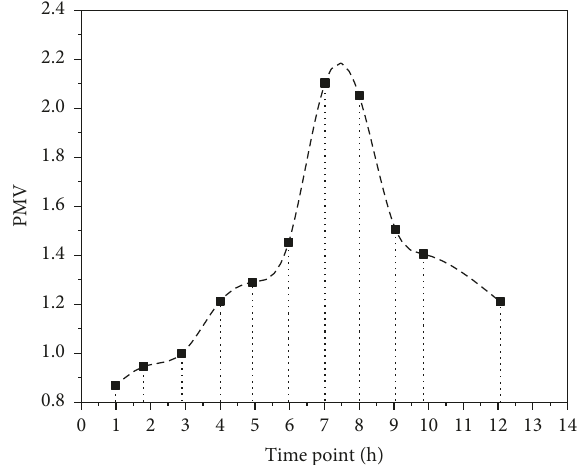
Figure 5: Variation of PMV with time at 28 ° C.